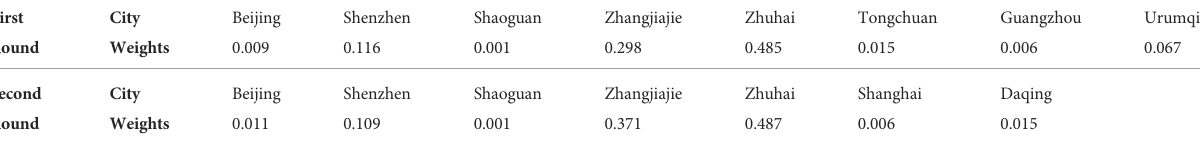
TABLE 4 City weights of synthetic Xiamen.